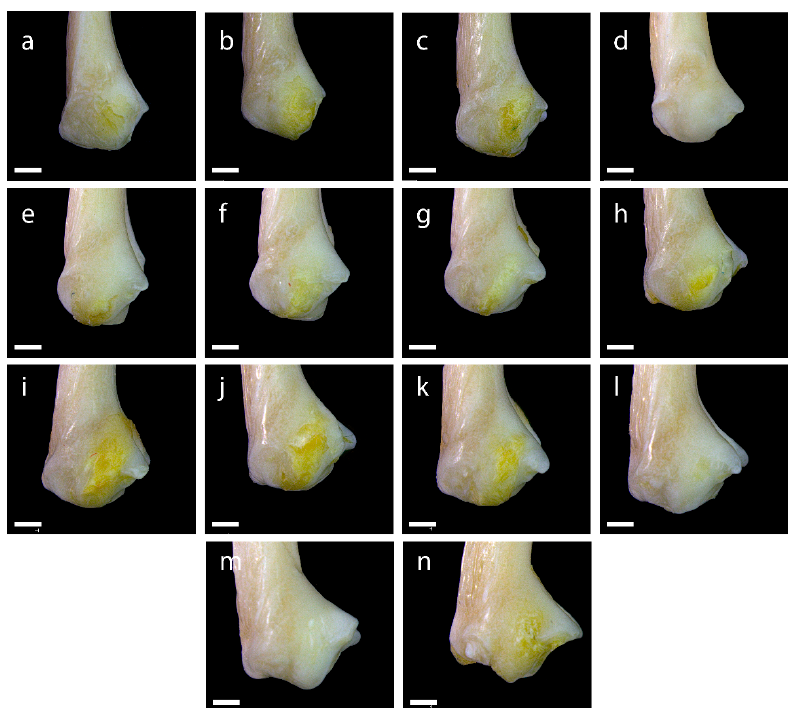
Figure A15. Microscopic images of the lateral left view of the pinnules of P. bichir PO6. The images ( a – n ) correspond to the 1st, 2nd, 3rd, 4th, 5th, 6th, 7th, 8th, 9th, 10th, 11th, 12th, 13th, 14th, and 15th pinnules, respectively. Scale = 1 mm.